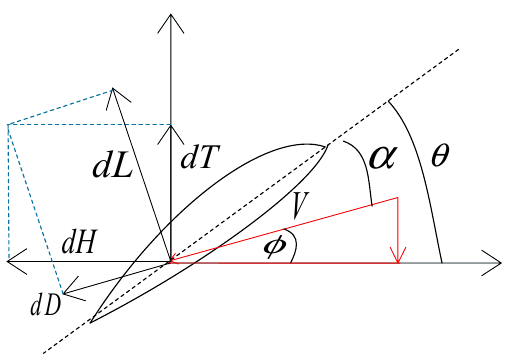
Figure 4. Vector diagram for a section dr a length r away from the center of the propeller.